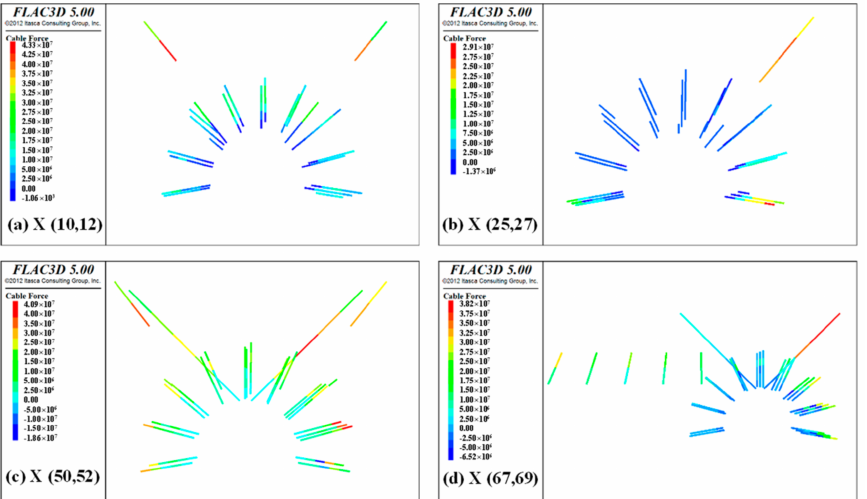
Figure 16. Cable force of the four monitoring areas after excavation of head chamber in belt